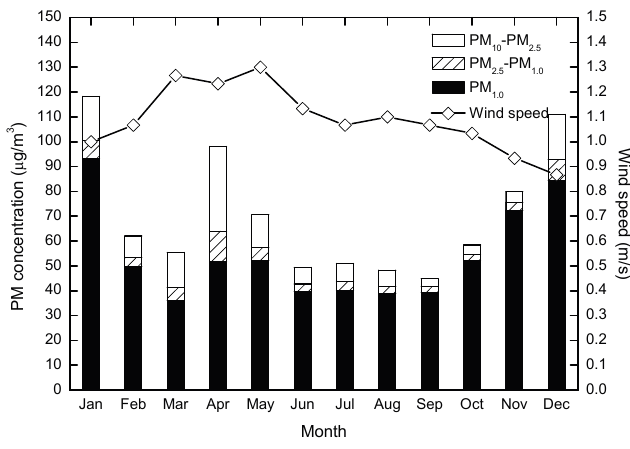
Figure 4. Variations in monthly mass concentrations of PM 10 , PM 2.5 and PM 1.0 related to average wind speed.